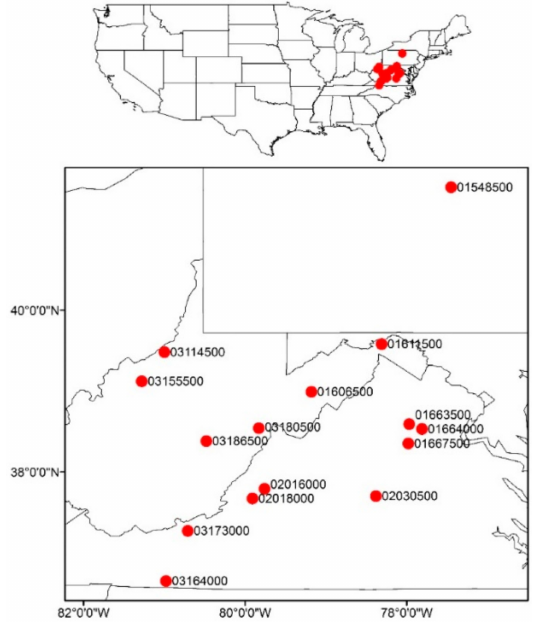
Figure 1. Location of the selected 15